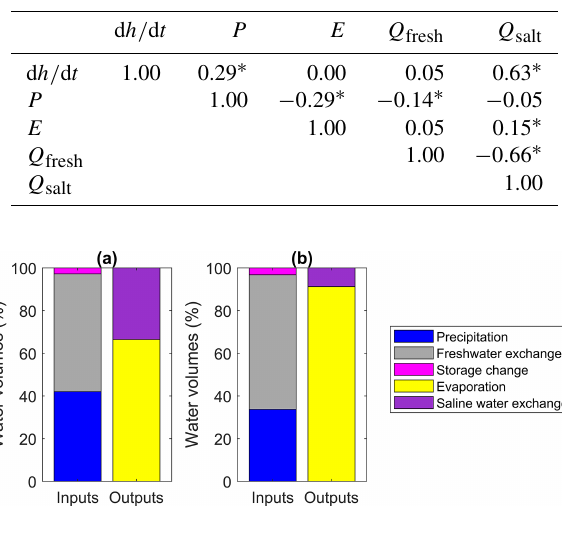
Figure 5. Water budgets over the whole study period for (a) current conditions and (b) future conditions (scenario C3: reduced precipi- tation and increased evaporation rate; see Table 2). Water volumes are expressed as a percentage of the total volume entering or leaving the lagoon, and only the net saline water exchanges are included in the